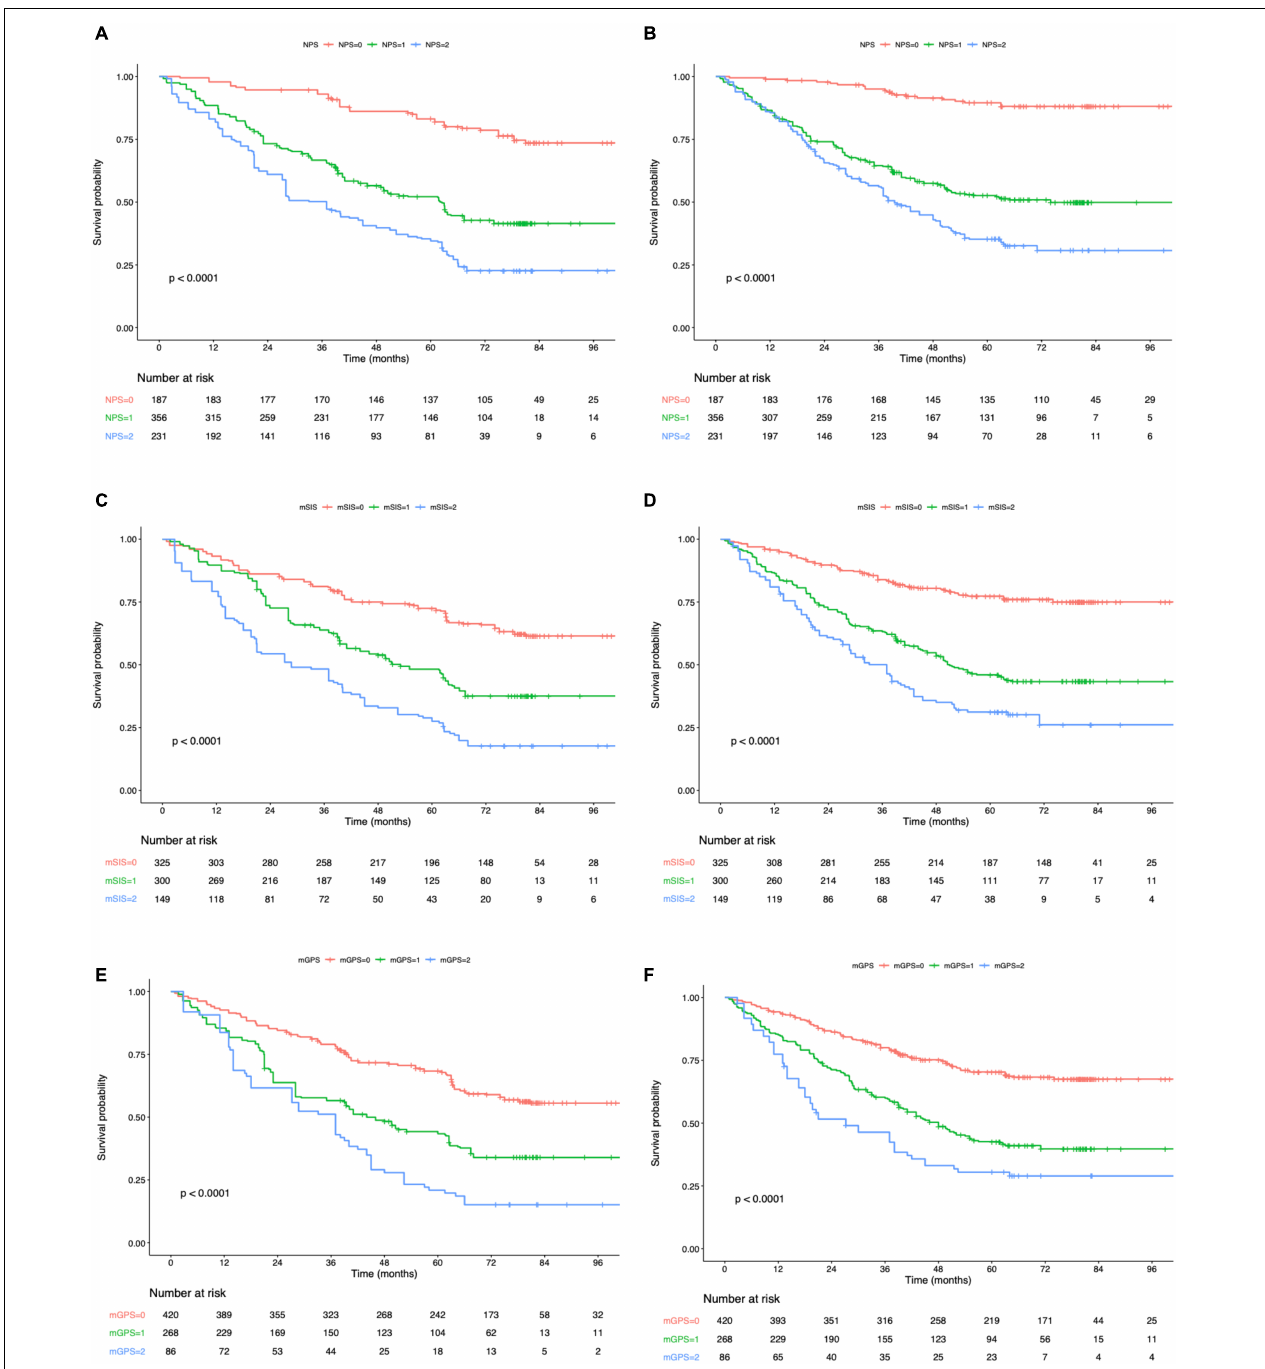
FIGURE 4 | Kaplan–Meier survival analysis of overall survival (A) and disease-free survival (B) according to NPS. Kaplan–Meier survival analysis of overall survival (C) and disease-free survival (D) according to mSIS. Kaplan–Meier survival analysis of overall survival (E) and disease-free survival (F) according to mGPS. NPS, Naples prognostic score; mSIS, modified systemic inflammation score; and mGPS, modified Glasgow prognostic score.